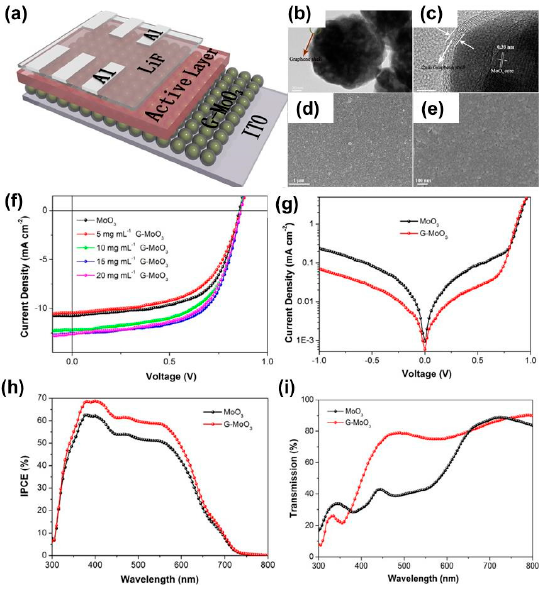
Figure 5. ( a ) Schematic diagram of PSCs showing the cross-sectional image of the device structure with the following layers: ITO / G-MoO 3 / PCDTBT:PC 71 BM / LiF / Al. ( b ) TEM image of G-MoO 3